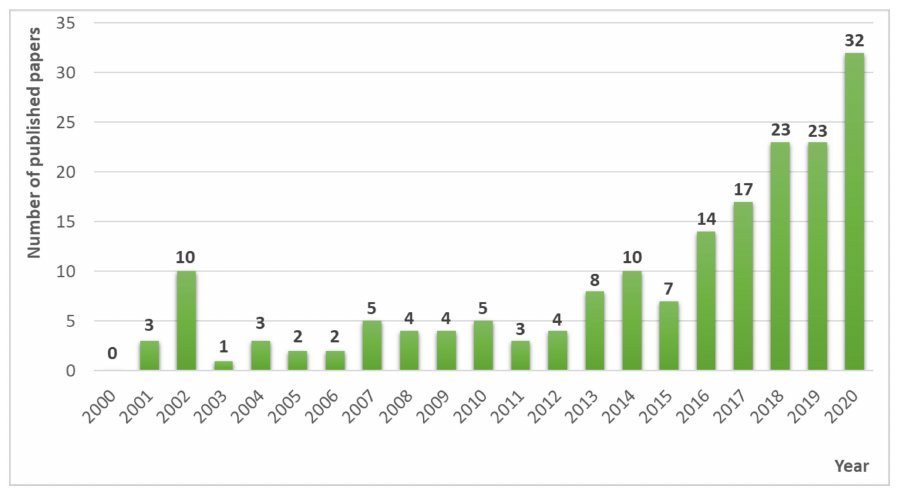
Figure 2. Number of original scientific articles on the use of chitosan and its derivatives and nanoparticles on cereals published between 2000 and